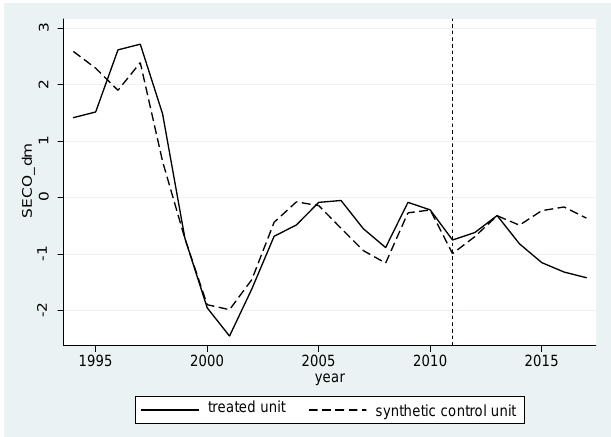
Figure 12. Outcome specification 5.